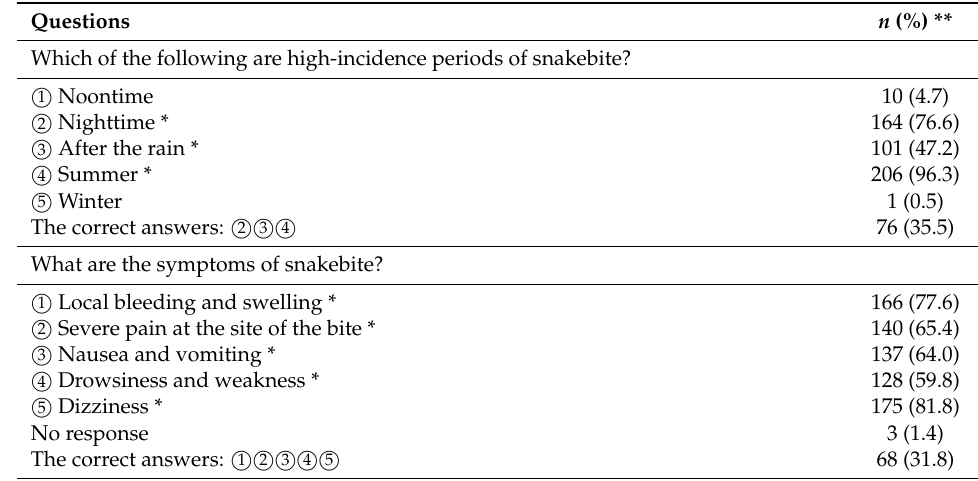
Table 2. General knowledge about snakebite ( n = 214).